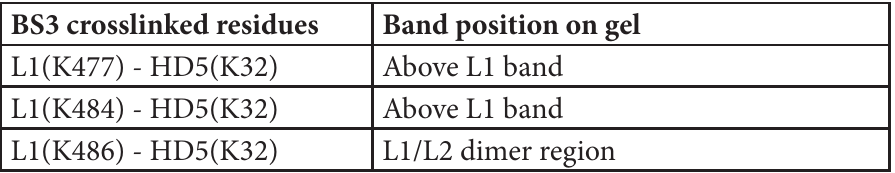
Table 1. Mass spectrometry detected BS3 crosslinks between L1 and HD5-R13K/R32K